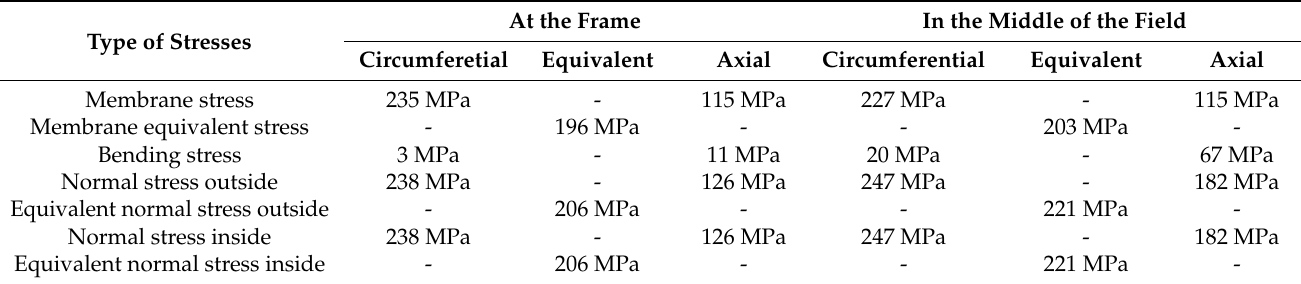
Table A3. Stresses at the test diving depth for the SFG baseline design in the free flooding compartment.